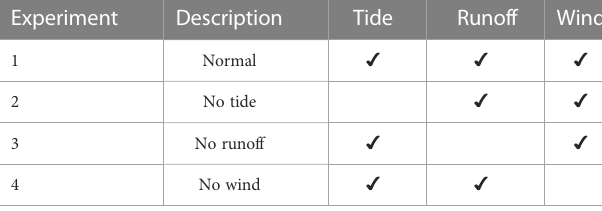
Figure 5A is true color composite image from the HY-1C satellites. The red lines show the red tide distribution (reddish- brown ribbons). The red tide drifted and diffused to the north and